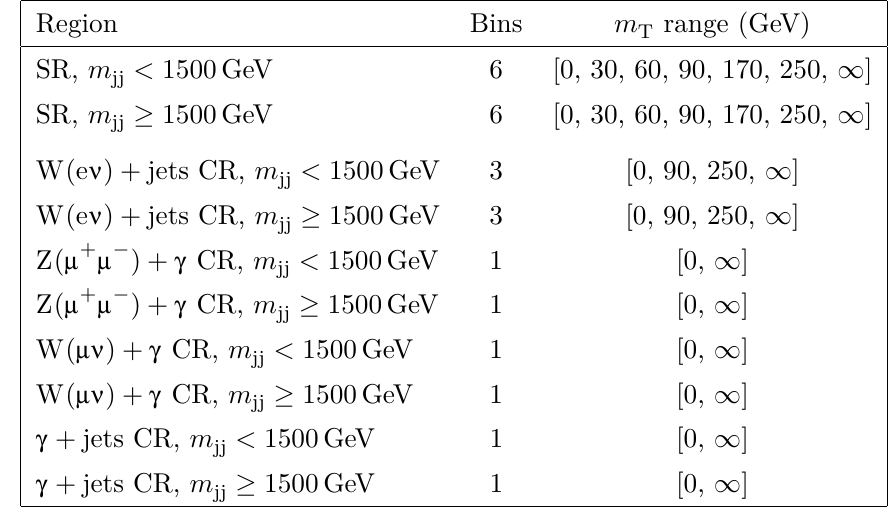
Table 2 . Summary of the m